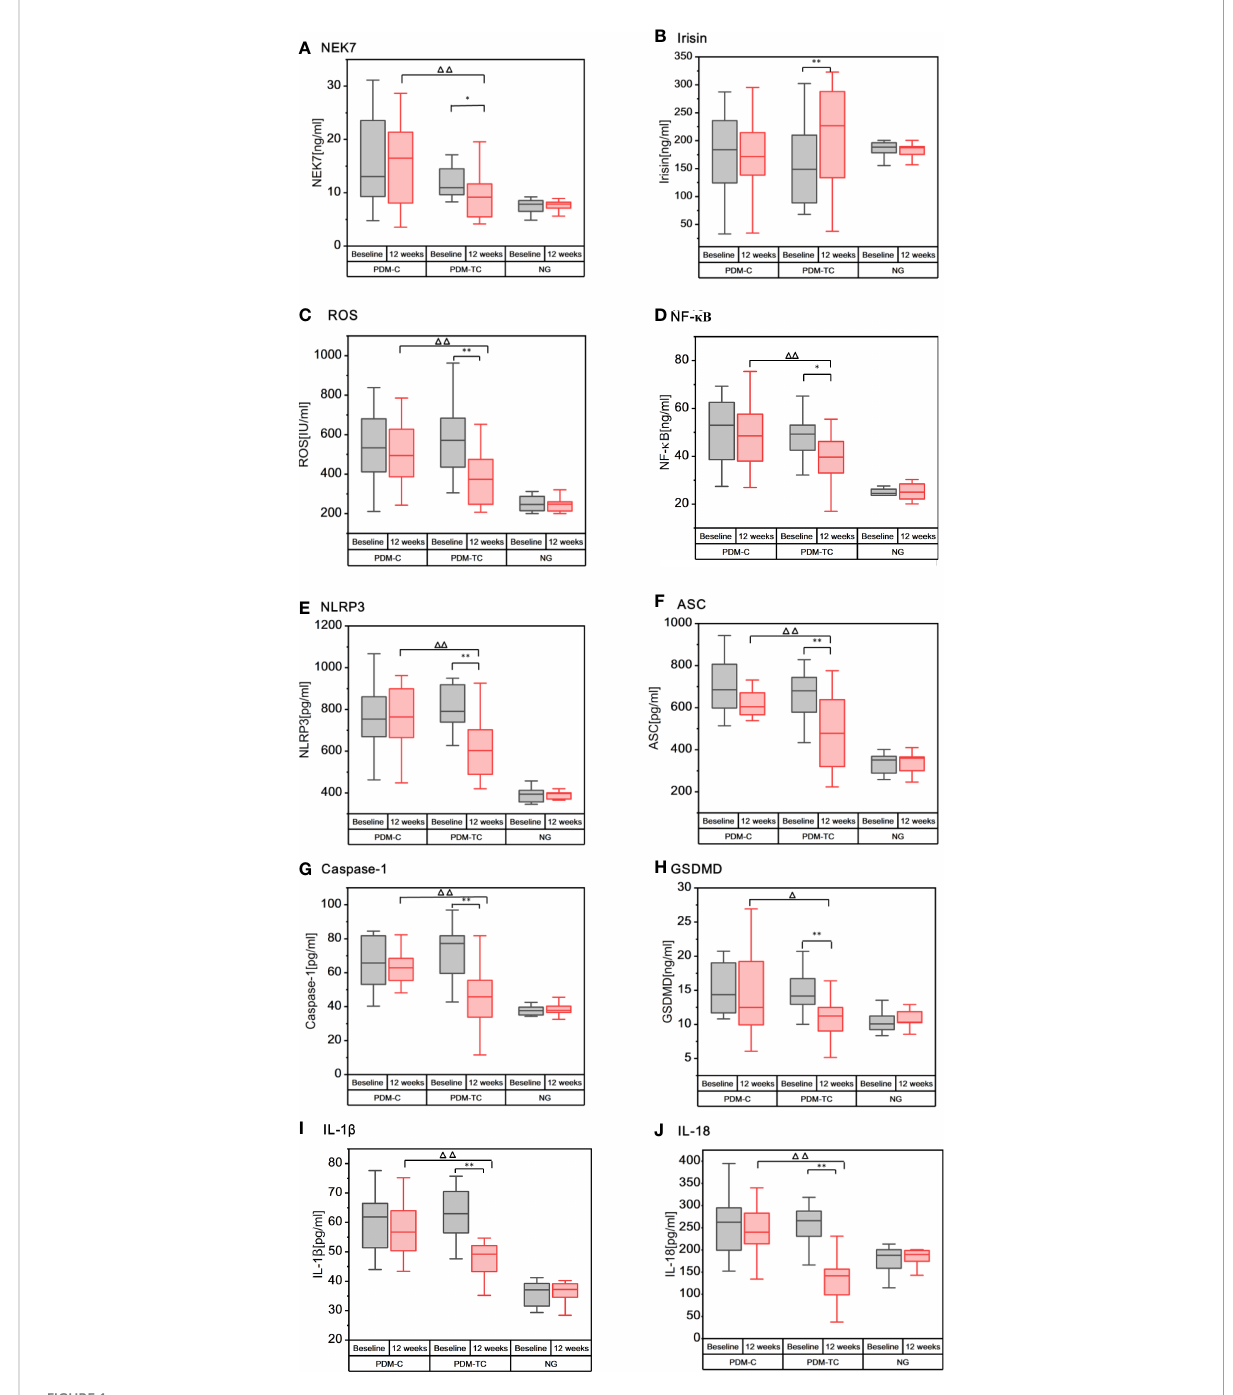
FIGURE 1 The expressions of in fl ammatory cytokines in the serum of patients with PDM-C, PDM-TC and NG groups, before and after 12 weeks of Tai Chi intervention. “ * ” indicates that there are differences within the group ( P < 0.05), and “ ** ” indicates that there is signi fi cant difference in the group ( P < 0.01). “ D “ indicates differences between the PDM-TC group and the PDM-C group ( P < 0.05), and “ DD “ indicates signi fi cant differences between the PDM-TC group and the PDM-C group ( P <